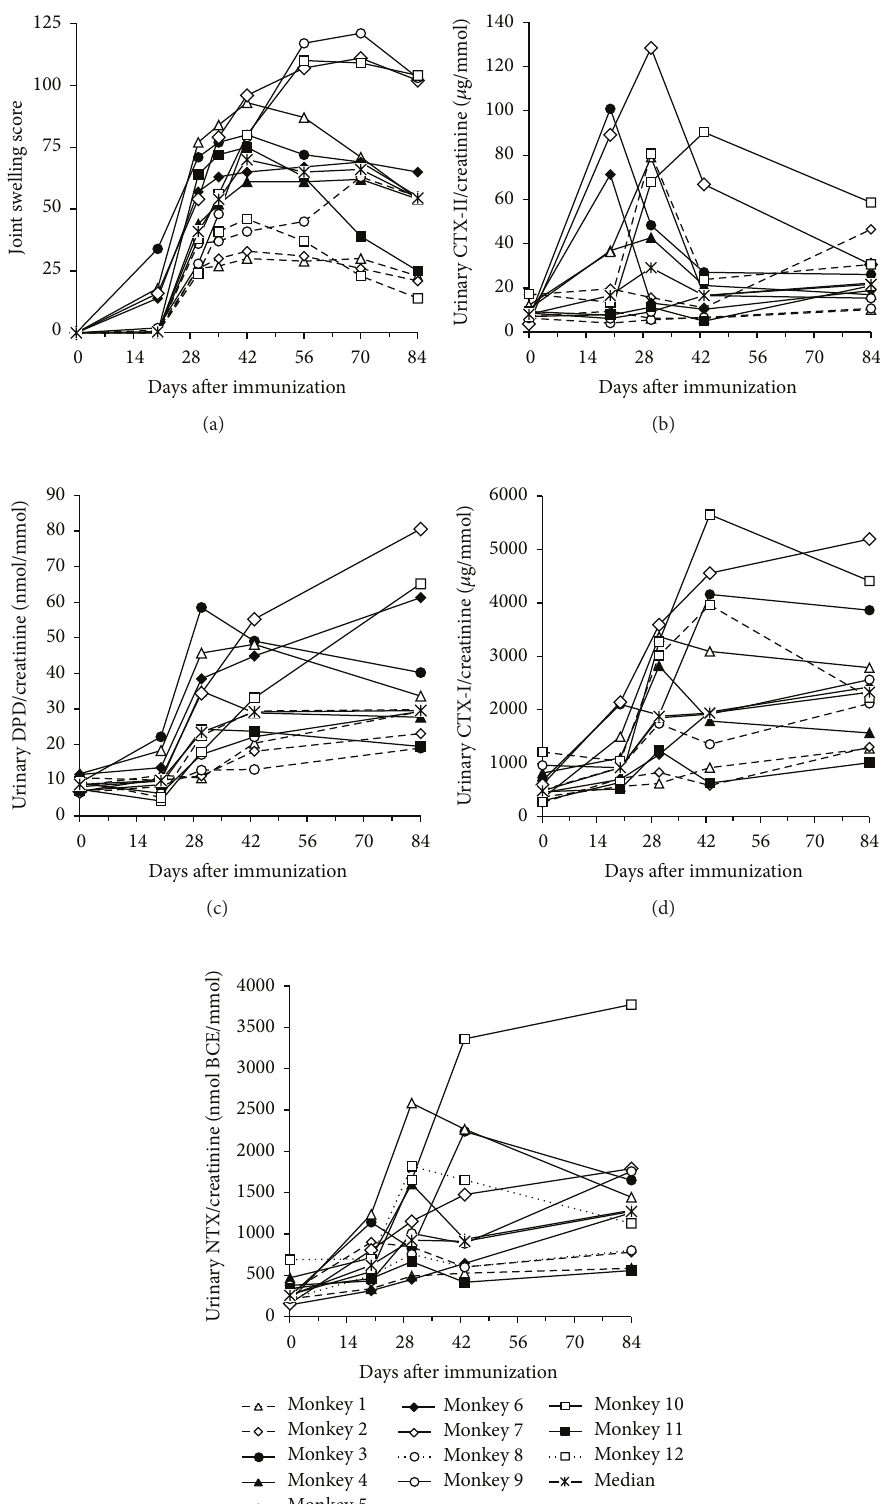
Figure 1: Joint swelling score, urinary cartilage marker (CTX-II/Cr), and bone turnover markers (CTX-I/Cr, NTX/Cr, and